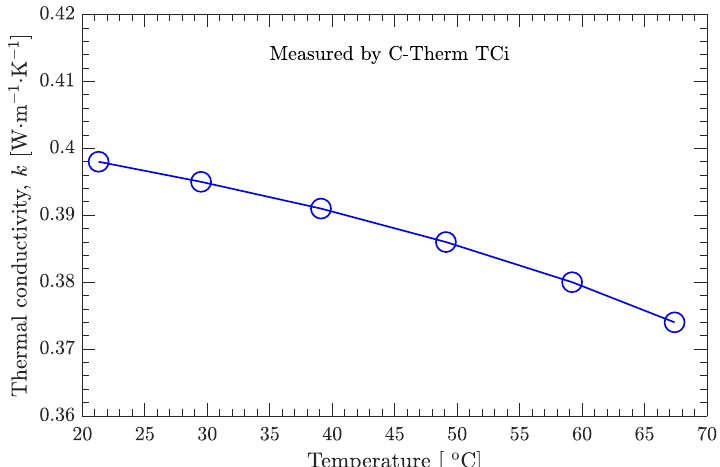
Figure 4. Thermal conductivity of the DNAN/HMX melt-cast explosive in the solid